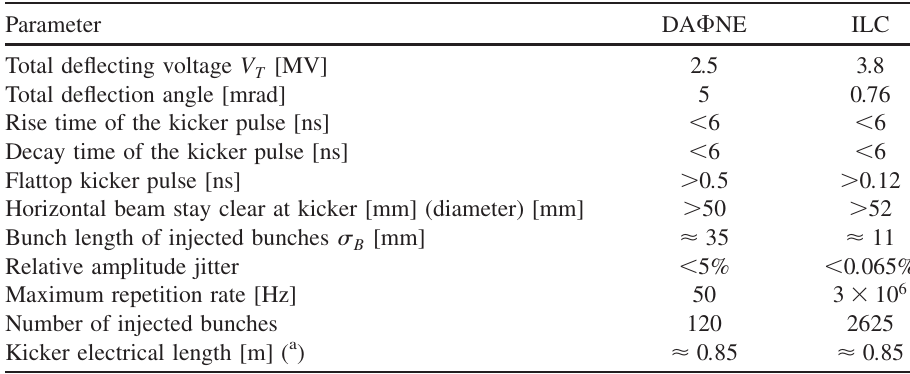
TABLE II. Parameters of the new DA(cid:1)NE kickers and ILC kickers (nominal parameters